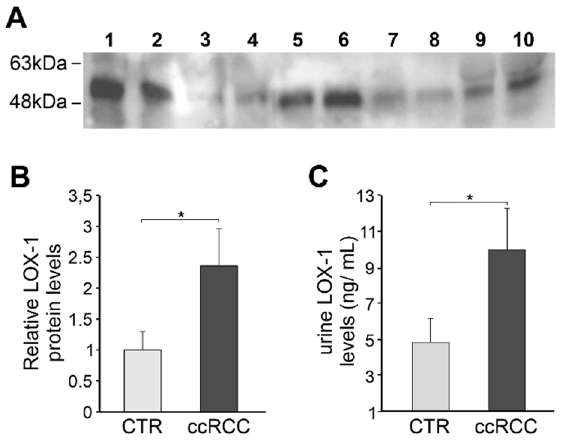
Figure 5. LOX-1 is revealed in urine of ccRC patients. ( A ) Representative Western blot analysis of equal amount of urine normalized with total protein from ccRCC patients ( n = 6; line:1-2-5-6-9-10) and controls ( n = 4; line:3-4-7-8). ( B ) Data are reported as mean ± SEM ( p -value = 0.05) LOX-1 levels analyzed by ELISA in ccRCC urine samples ( n = 30) and healthy controls ( n = 25). ( C ) Data are reported as mean ± SEM (* p -value < 0.05).